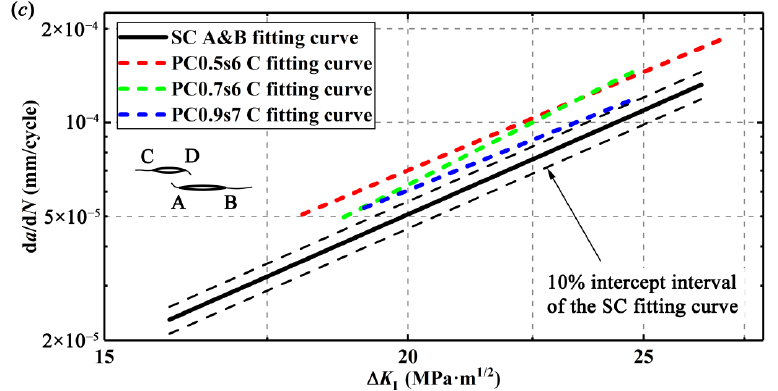
Figure 11. d a /d N vs. Δ K I : ( a ) for single crack and double equal cracks, ( b ) for single crack and crack tip